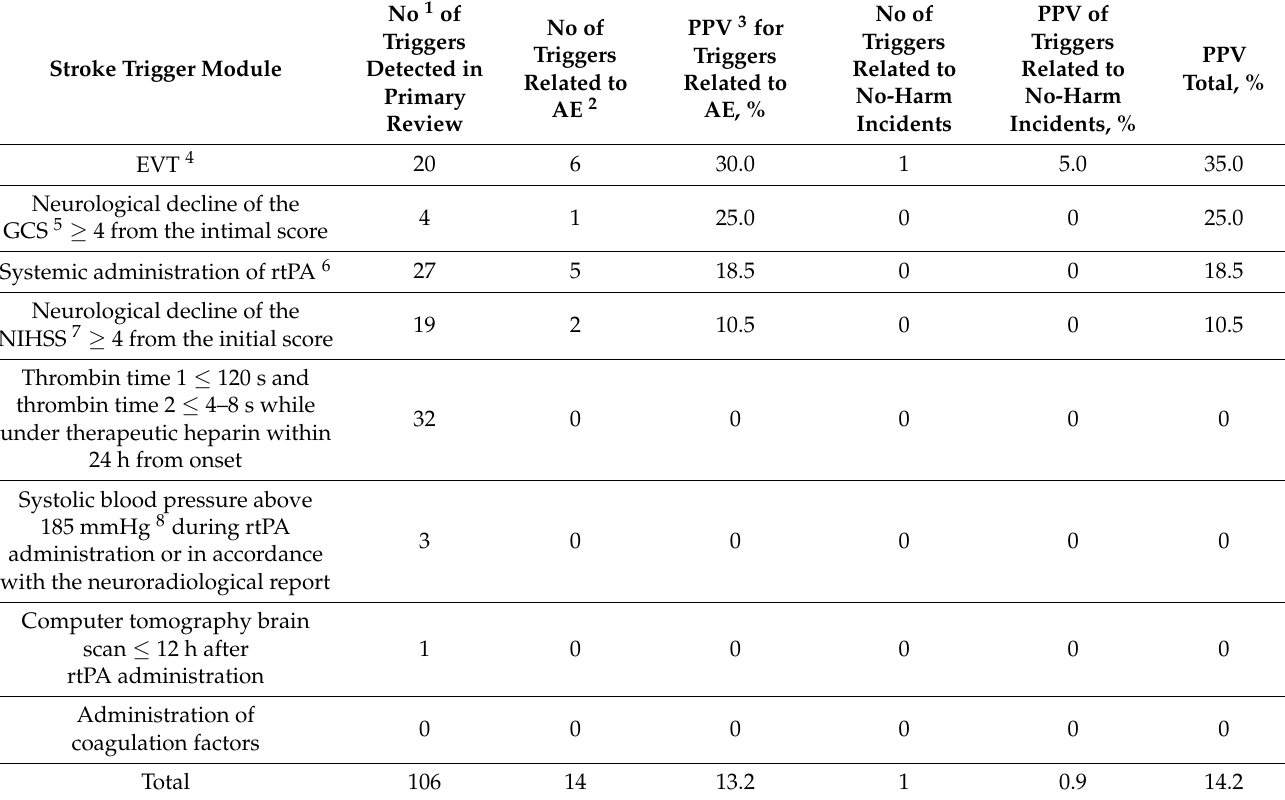
Table 5. Appended stroke module with frequency of trigger occurrence and positive predictive